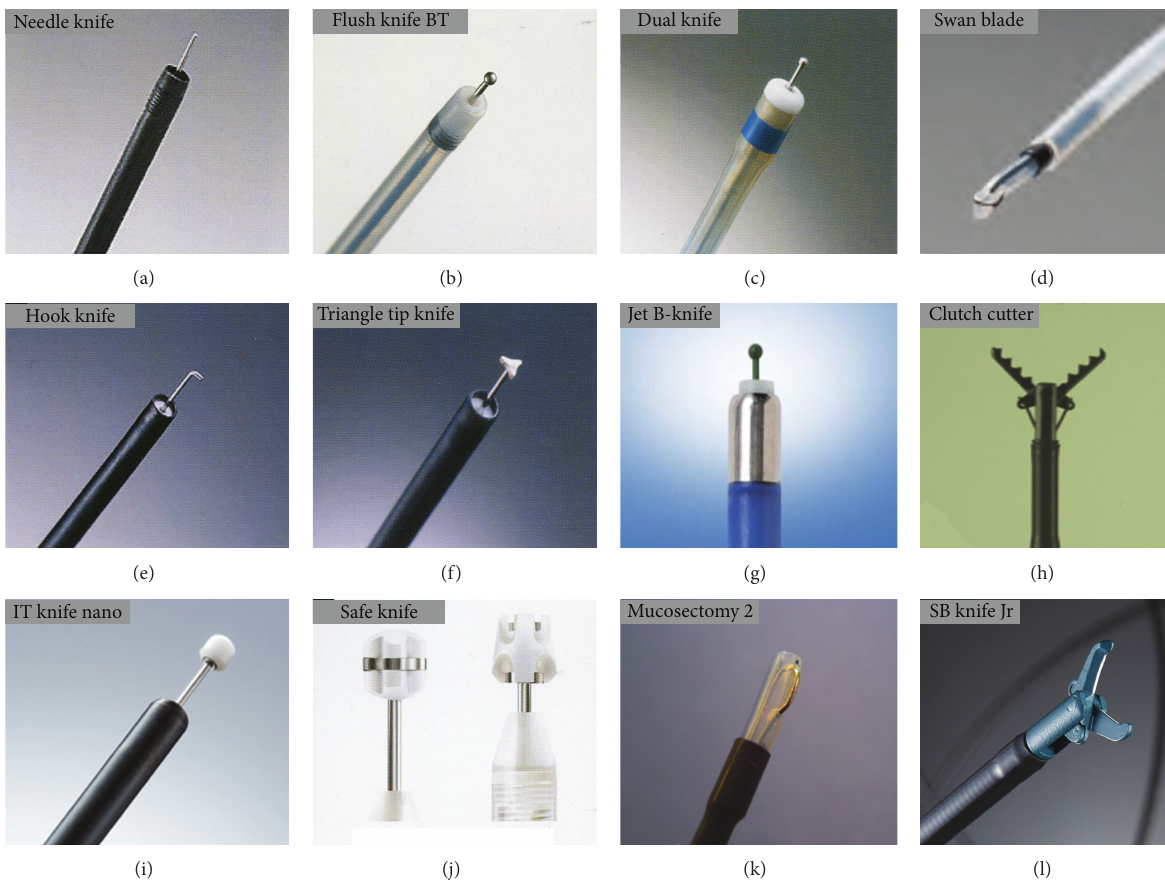
Figure 2: Various knives used for endoscopic submucosal dissection.